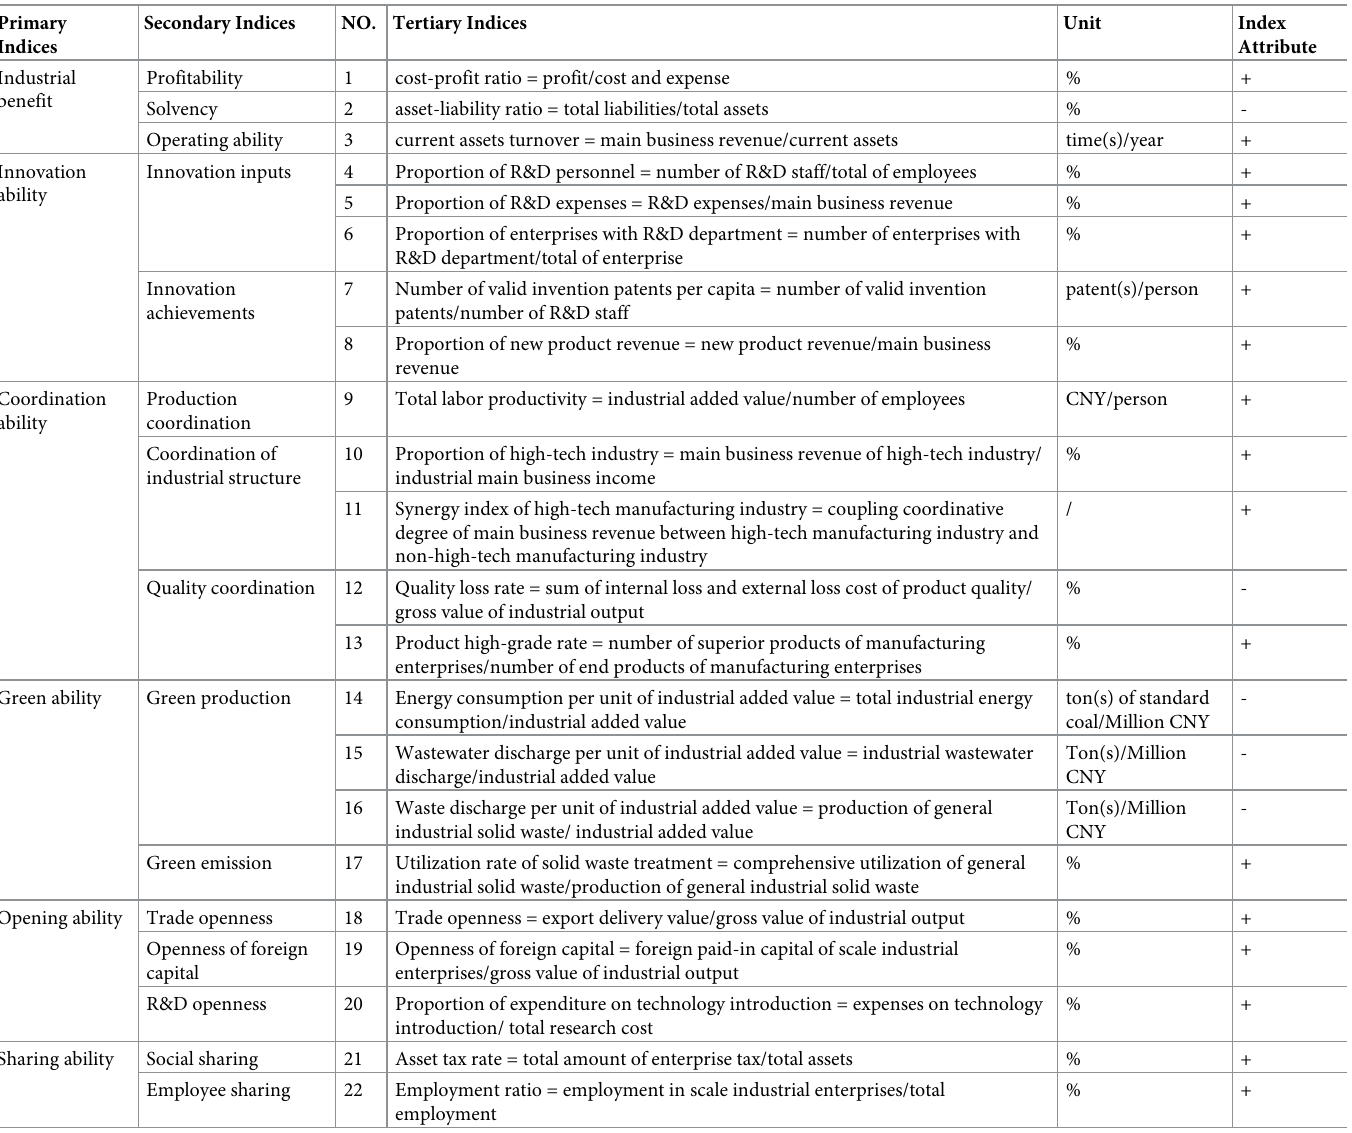
Table 1. Evaluation index system of high-quality development level of industry in